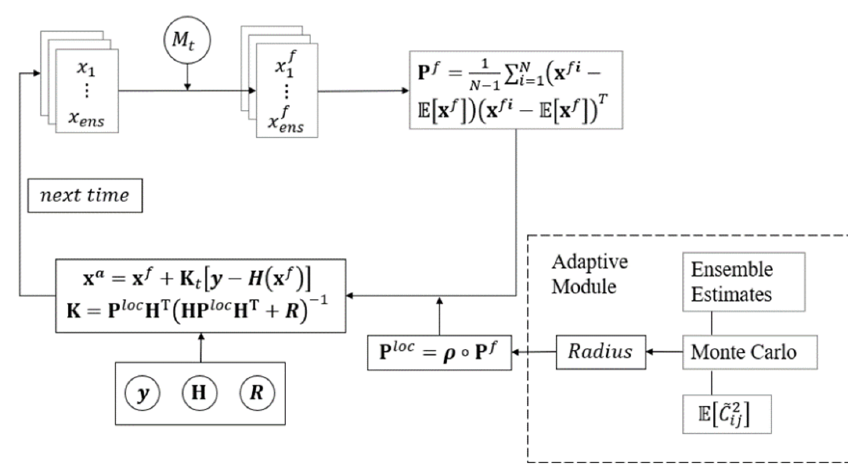
Figure 4. The flowchart of the adaptive covariance localization in the ensemble